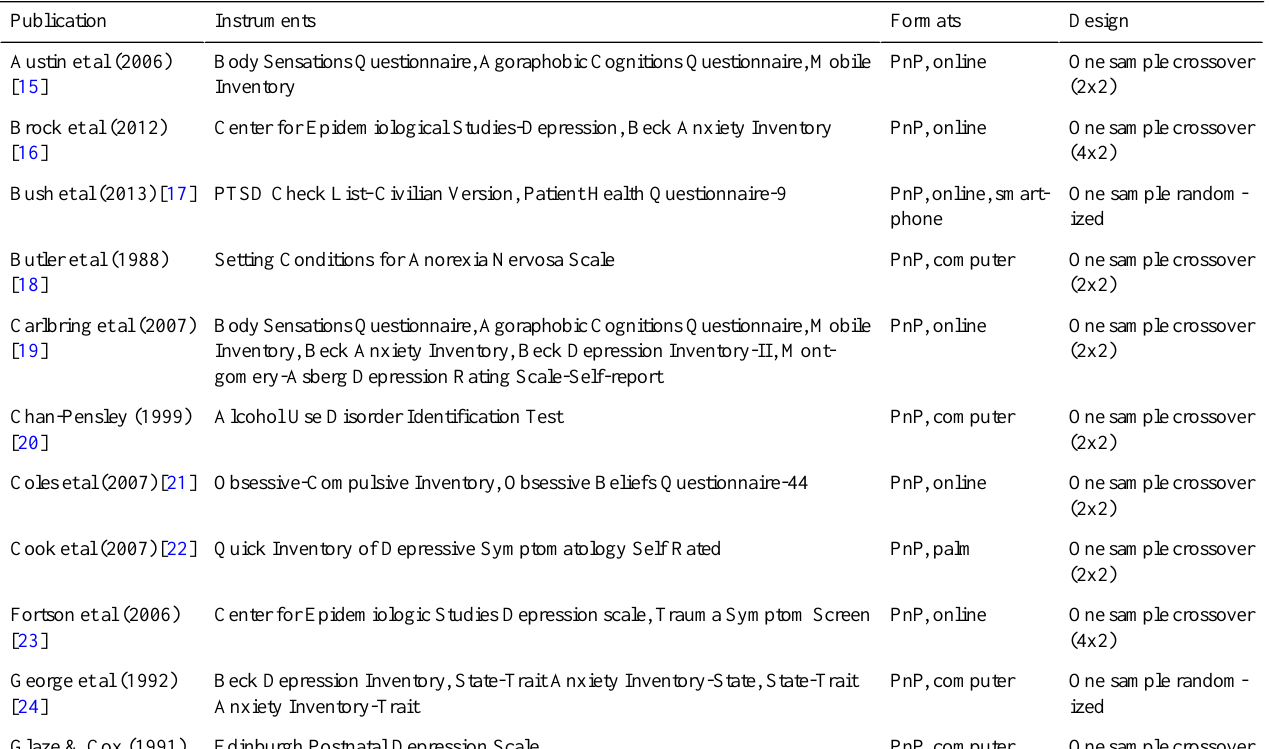
Table 1. Included publications, investigated instruments, formats compared, and study